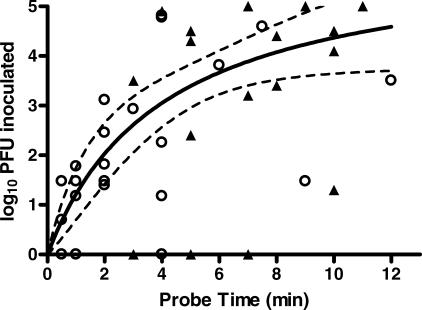
Amount of WNV Inoculated by Mosquitoes into Mouse Tails Increases with Probing TimeIncluded on graph are data from the probe time experiment (open circles) and from other experiments (filled triangles) in which parenterally or orally infected Cx. tarsalis probed and fed on a mouse tail. Solid line shows best-fit one-site binding model, and dotted lines show 95% confidence band of the best-fit curve. LOD of plaque assay was 5 PFU. Values less than the LOD are reported as 0.